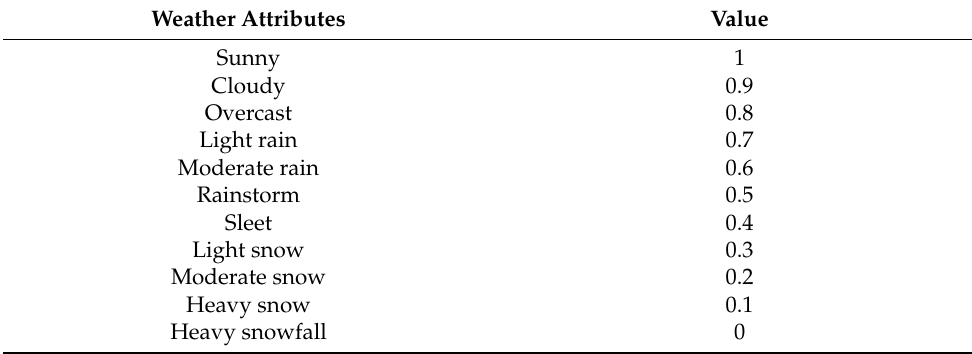
Table 1. Quantitative treatment table of weather attribute eigenvalue.